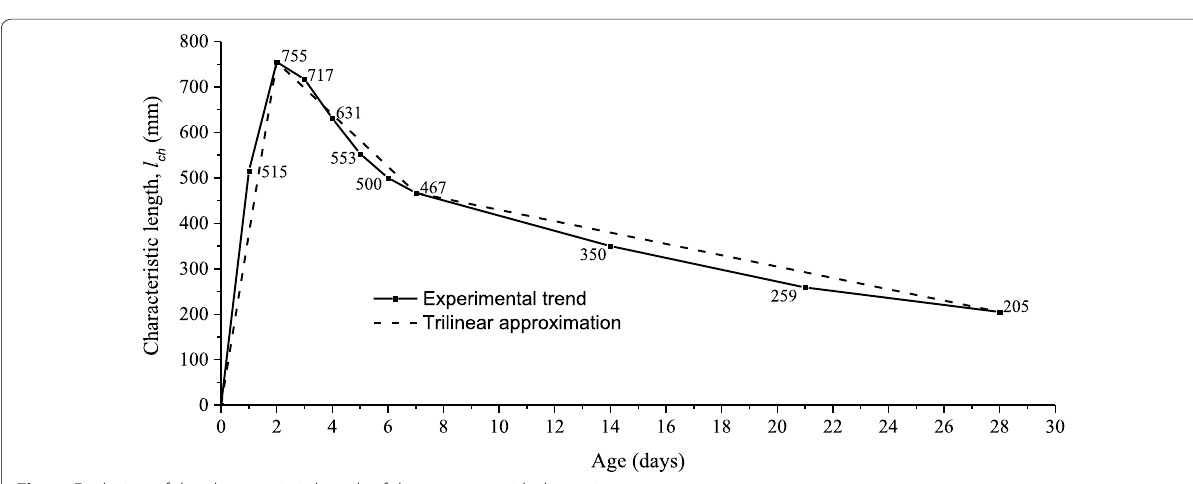
Fig. 6 Evolution of the fracture energy of the concrete with the curing age.